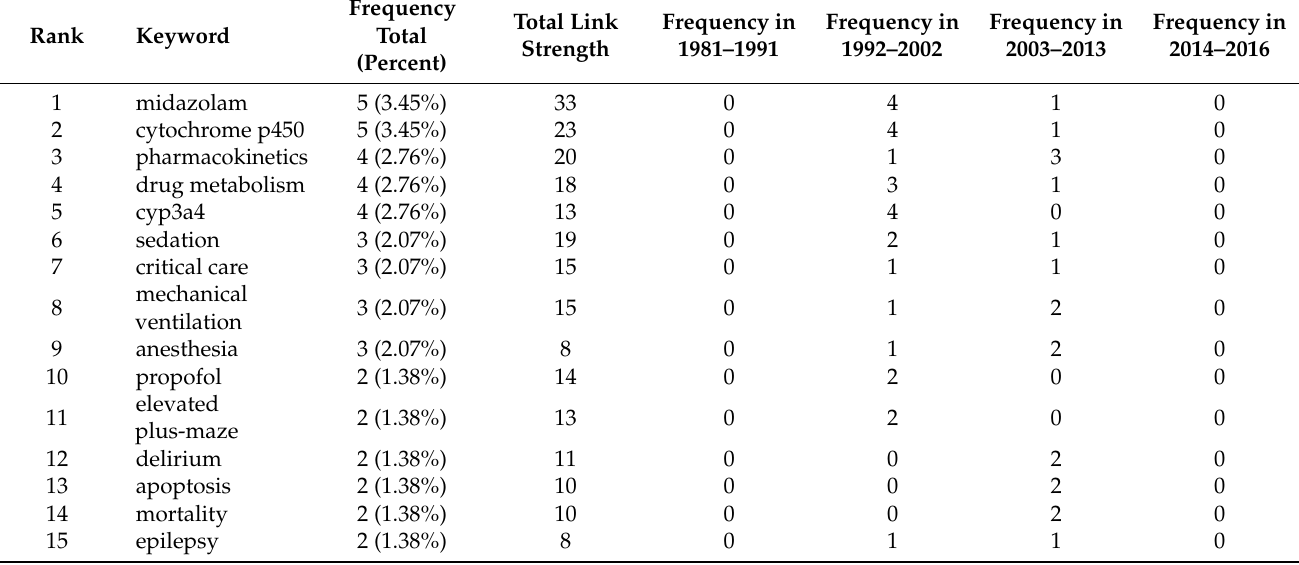
Table 3. Most frequent author-keywords (at least two occurrences) of the 100 most-cited studies about Midazolam.